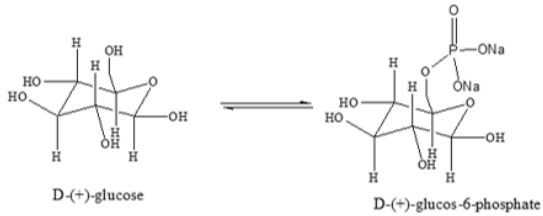
Figure 11. Formation of D-(+)-glucos-6-phosphate during electrochemical process.